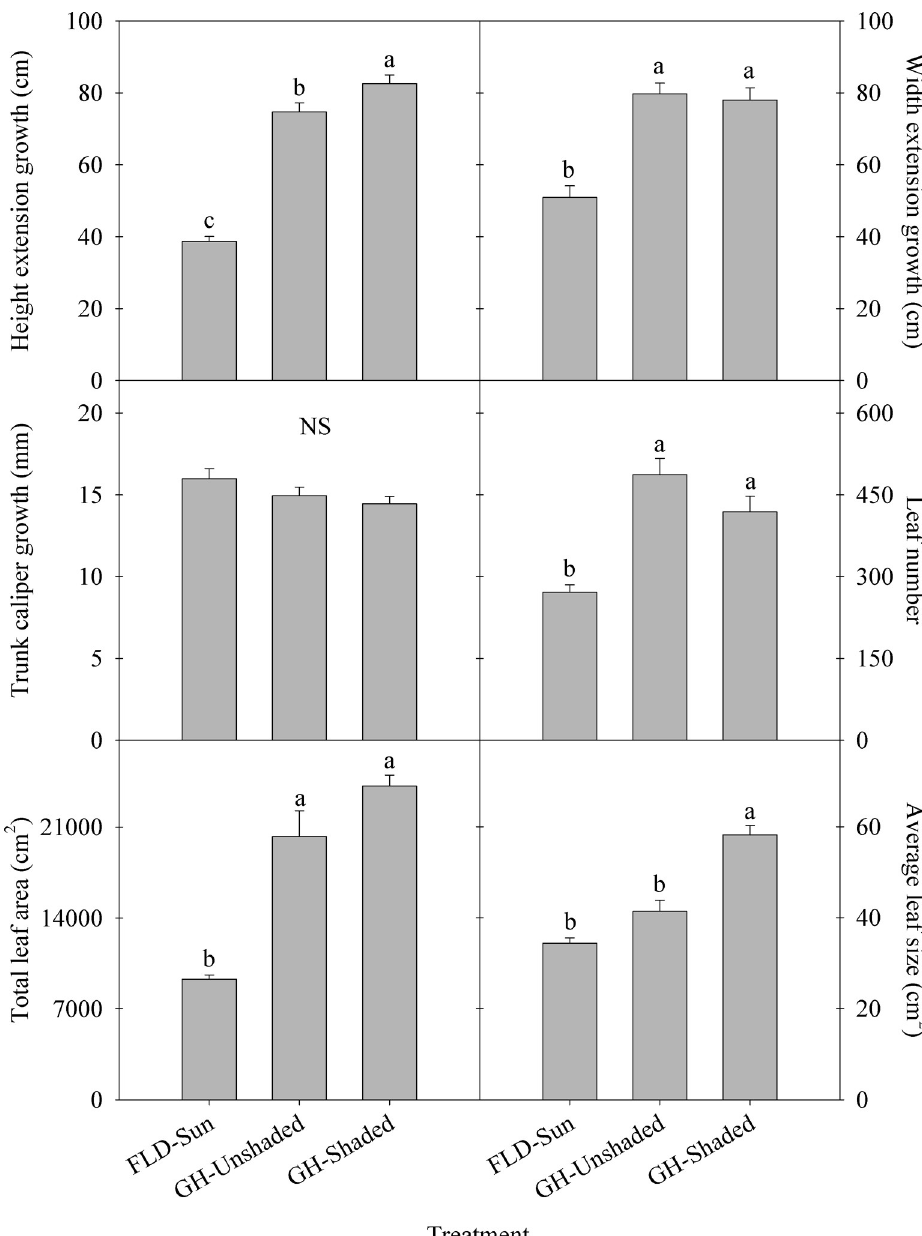
Fig 2. Average plant growth indicators of kratom cultivated over time under varying radiance. FLD = field; GH = greenhouse. Leaf number included leaves � 2 cm. Data were pooled from twenty replicates per treatment (n = 60) for height, width, and trunk caliper growth and four random replicates per treatment (n = 12) for leaf number, total leaf area and average leaf size. Means sharing the same letter are not statistically different by Tukey’s honest significant difference test at P < 0 . 05 . Error bars indicate the standard error. NS = not